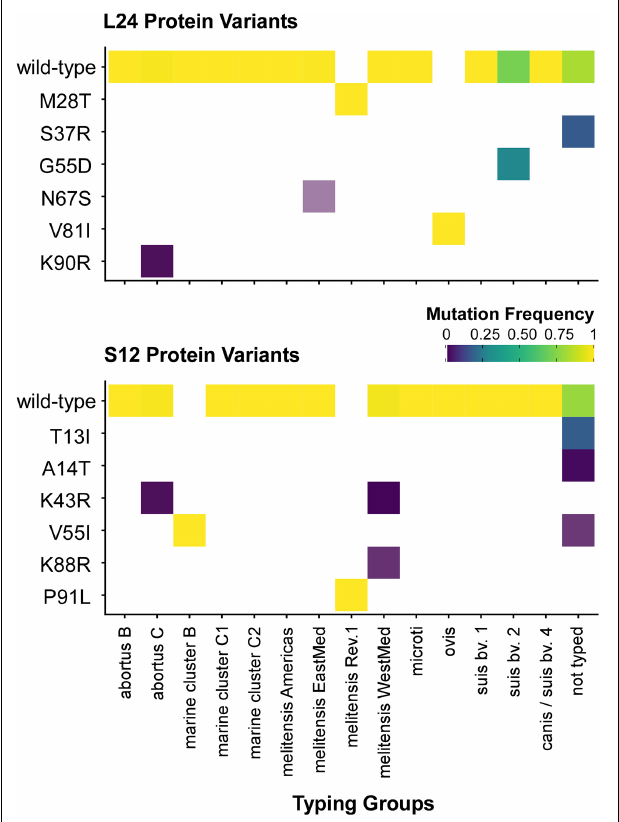
FIGURE 5 | Distribution of ribosomal protein L24 and S12 variants in 802 Brucella genomes from the NCBI dataset. The heatmap coloring shows the frequency of each variant in the MLVA typing groups (white: no